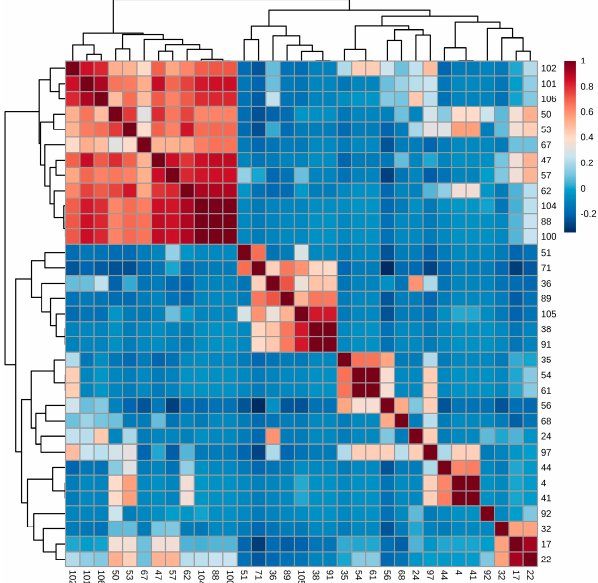
Figure 4. Results of Pearson correlation for the most important compounds presented as heat map with hierarchical clustering.